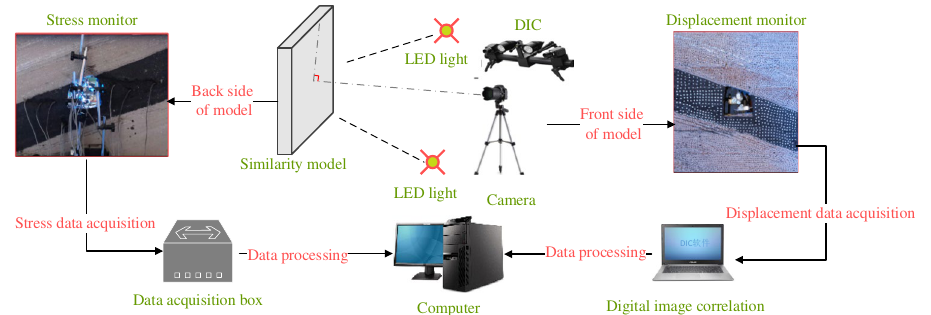
Figure 6. Flow chart of roadway deformation monitoring.